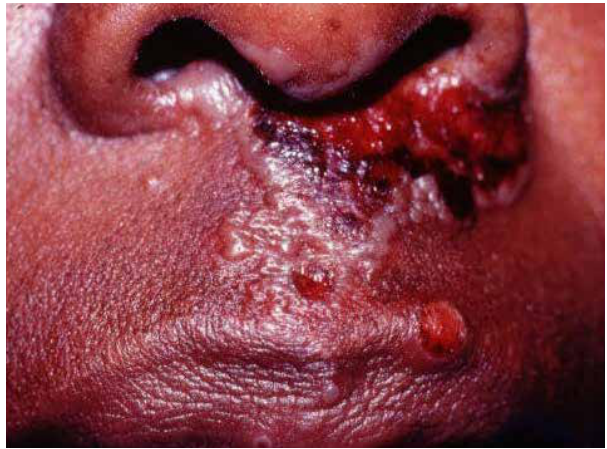
Figure 1. Herpes labialis in an HIV- infected patient